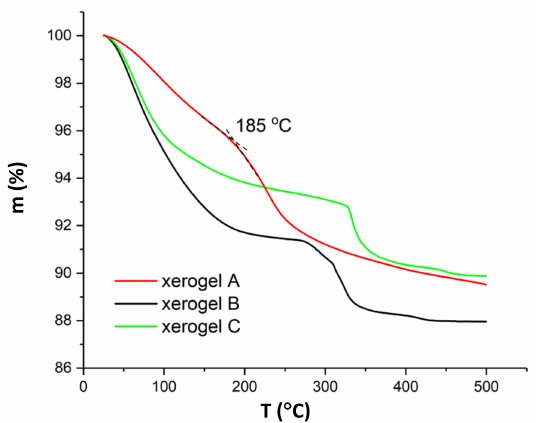
Figure 2. TG measurement of the WO 3 xerogels prepared with different solvents: xerogel A with 2-propoxy ethanol and 2-propanol; xerogel B with ethanol and xerogel C with 2-propanol.